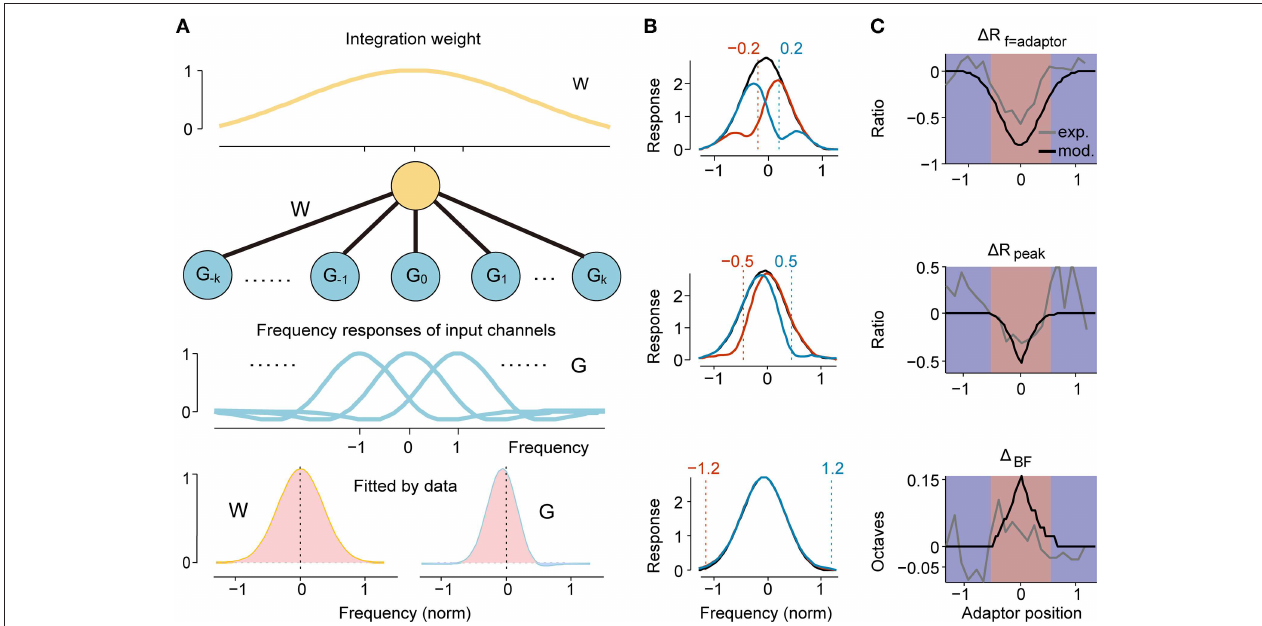
FIGURE 4 | Two-layer feedforward network model predicted RF Change. (A) The architecture of our two-layer feedforward network. The upper neuron integrates weighted inputs (W function, yellow line in top panel). Each channel in the lower input layer has a specific frequency response organized tonotopically (G function, blue lines). When a specific frequency is repeatedly presented, the input from the adaptor channel is suppressed, resulting in a change in the output as observed in the upper layer neurons. Both W and G are modeled as Gabor functions with individual parameters. Bottom: the W function and G function with parameters fitted by experimental data of narrowly tuned neurons. Light red and light blue indicate excitatory and inhibitory sub-regions, respectively. (B) The simulated adapted (colored) and original tunings (black) by six different adaptors qualitatively depict the experimental observation. The normalized frequency of each adaptor is annotated with a dashed line and the text above it. (C) The profile of the ratio of change in adaptor response (top), peak response (middle) and shift magnitude (bottom) with respect to the adaptor position from model simulation (black) and the experiment (gray) match well in the overall center-surround pattern.